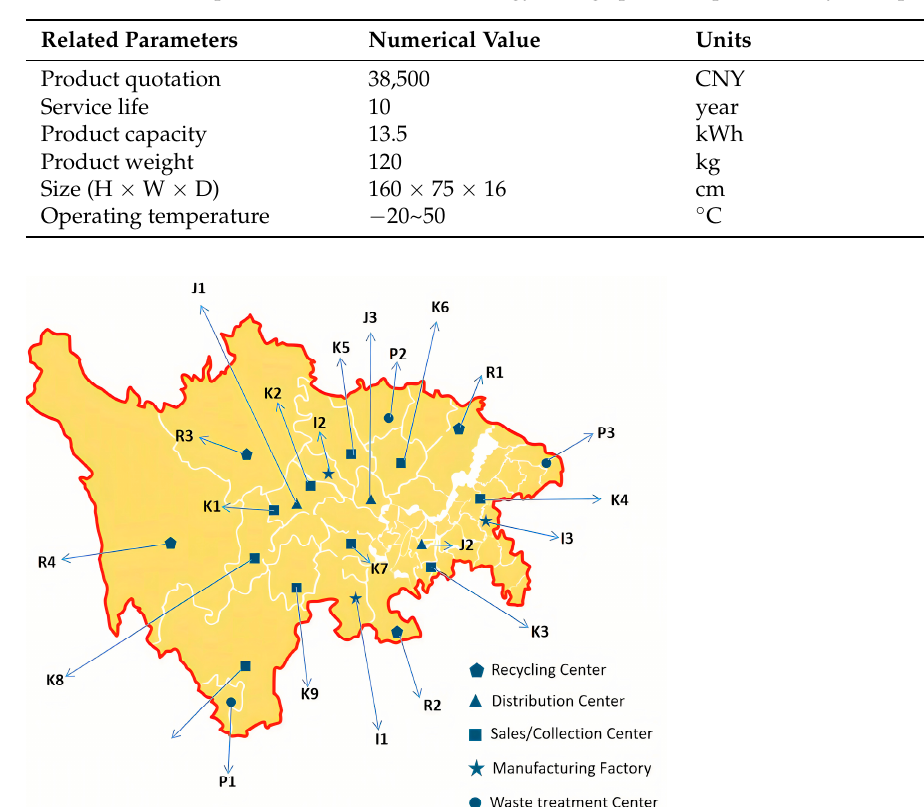
( b ) Recycling network of scheme 2 Figure 6. Comparison diagram of recovery network between scheme 1 and scheme 2.